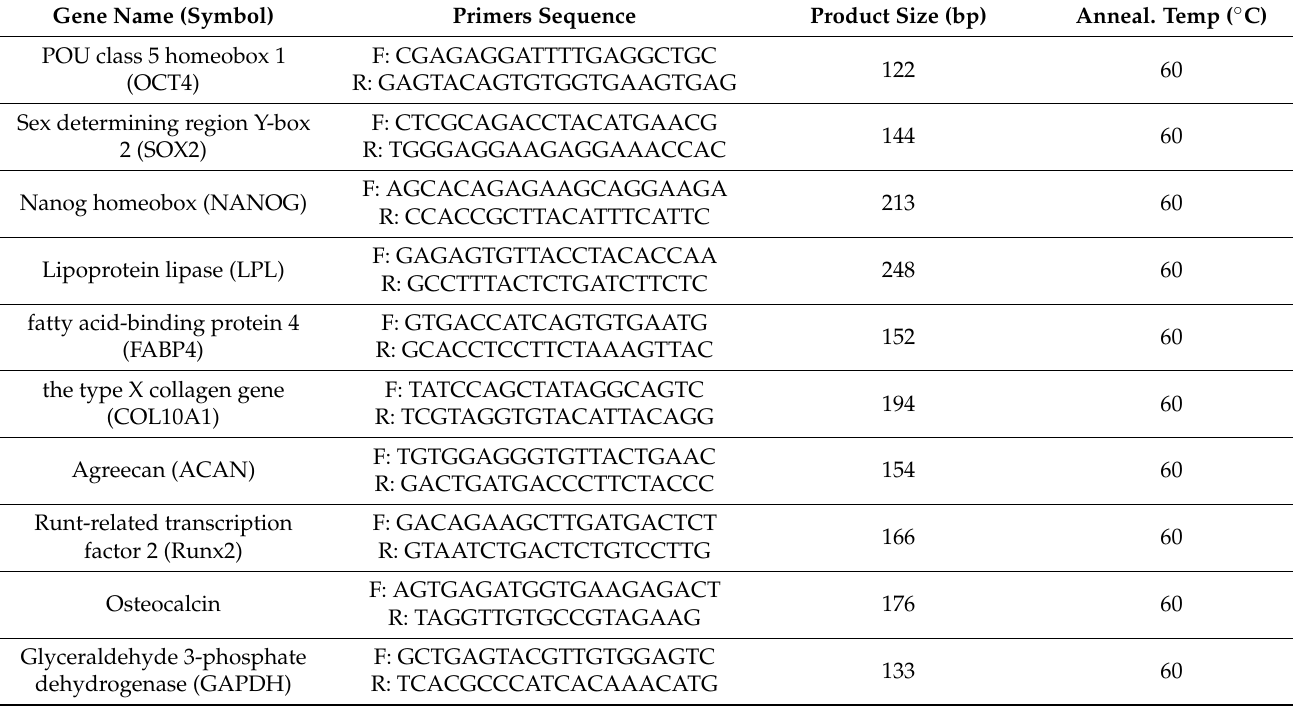
Table 1. Lists of camel primers used in real-time quantitative polymerase chain reaction (RT-qPCR)